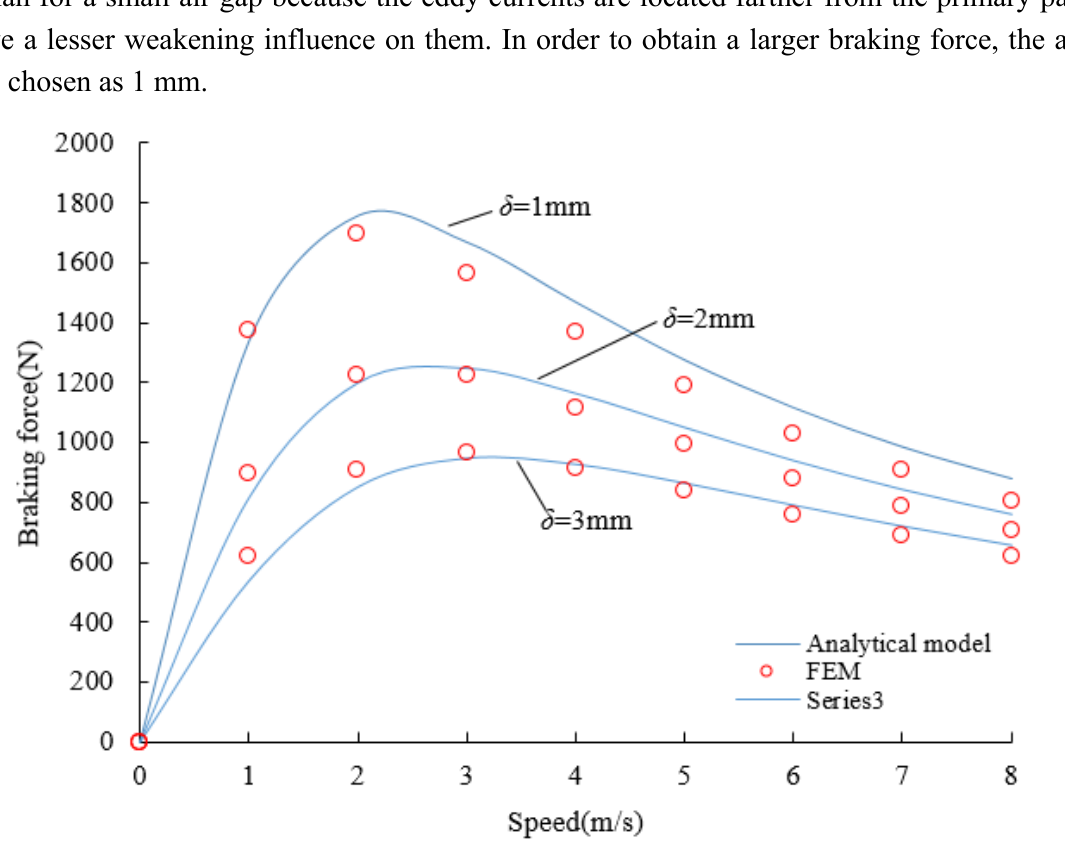
Figure 8. Braking force-speed characteristic for different air gap